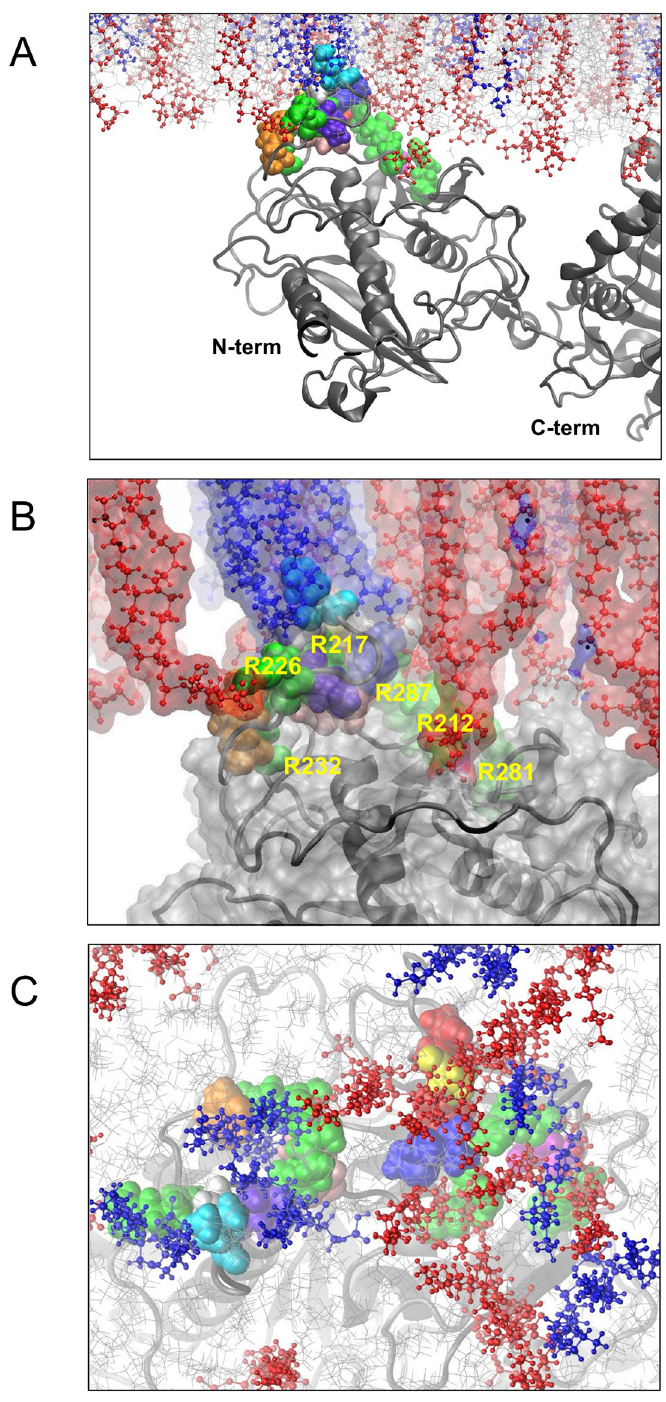
Fig 10. Molecular image of the largest cluster on the PH domain at 3 μ s. A side view of protein and membrane; B side view of the molecular surface plot of the binding pocket; C view looking from the bilayer midplane up at the protein. Coloring is as follows: (for lipids) PIP 2 , red small spheres; POPA, blue small spheres; other lipids, gray lines; (for amino acids, space-filling) R, green; T, red; S, magenta; M, blue; A, yellow; V, violet; Y, orange; H, pink; L, cyan; G, silver. Other protein residues in gray ribbon style. The molecular surface was calculated based on van der Waals radii with a probe radius of 1.4 Å using the “Surf” module in VMD [72]. Water and ions are not displayed.